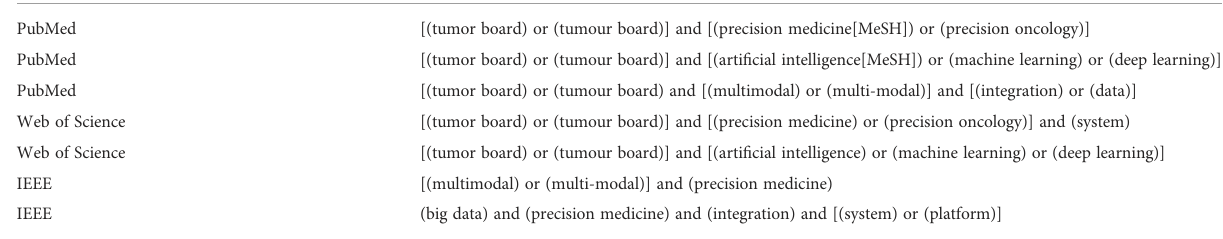
TABLE 1 Search strategy for scoping review.